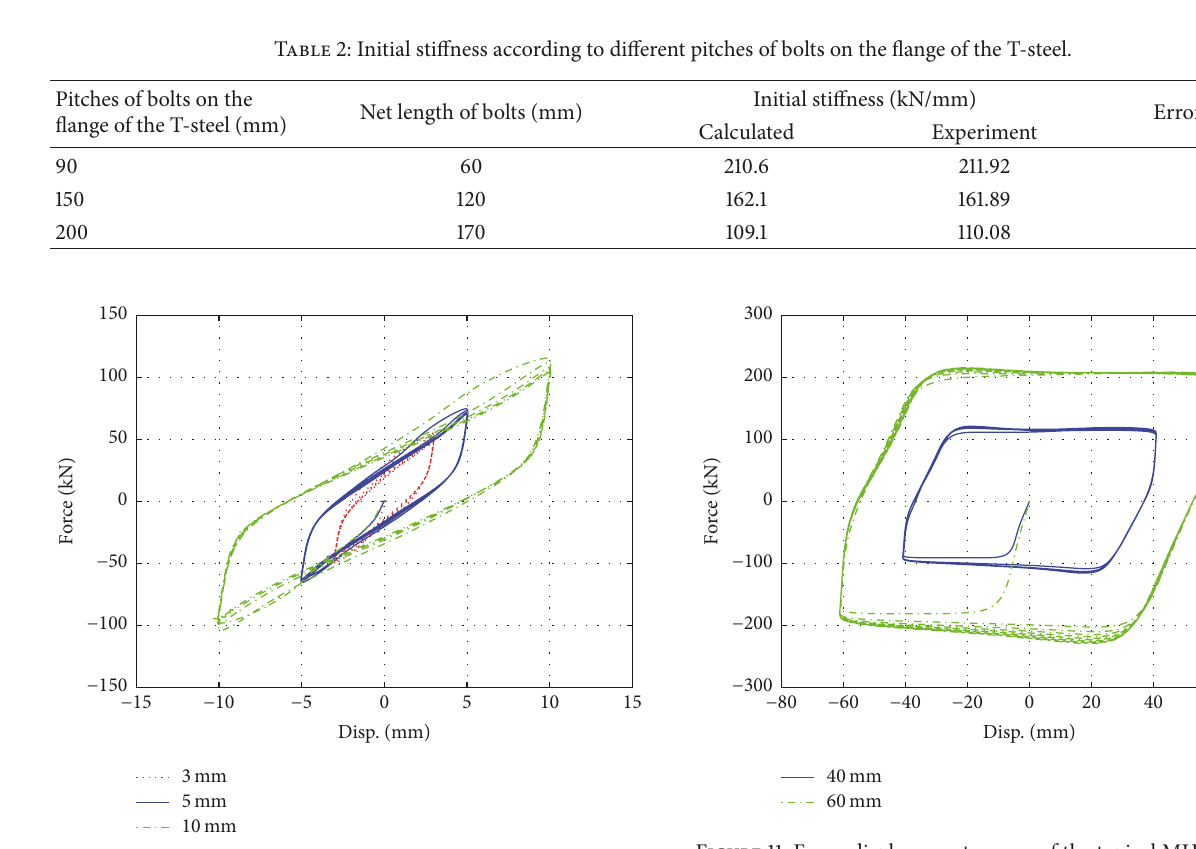
Figure 10: Force-displacement curves of the typical MHD for small deformation.